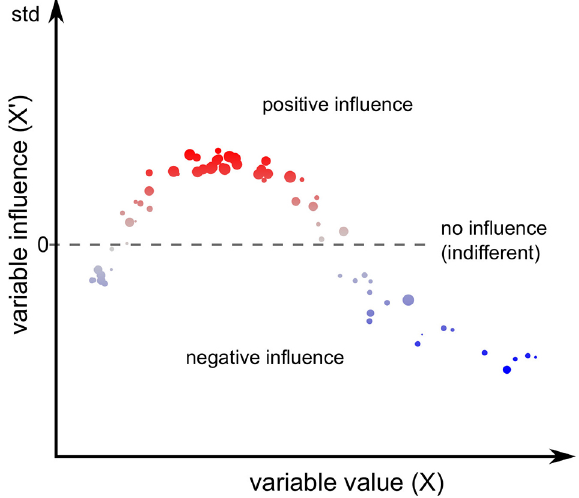
Fig. 4. The concept of mapping variable values into influence. The size of dots simulates the values of the dependent variable.